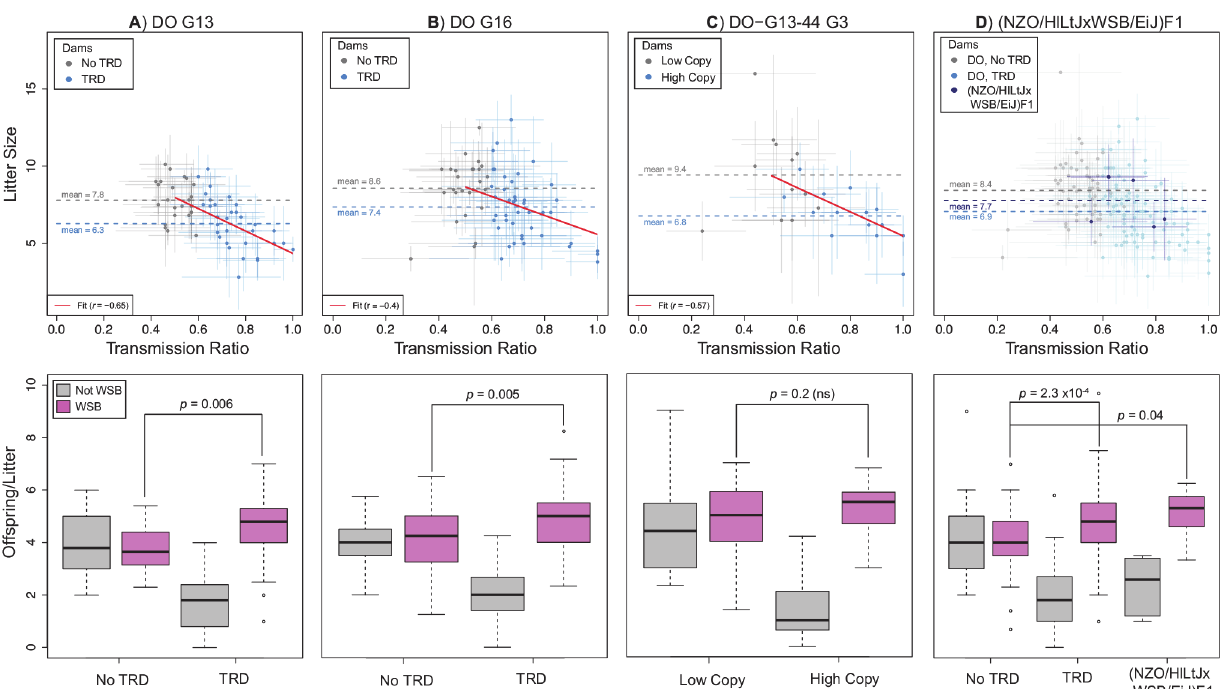
Figure 5. TRD at R2d2 requires the combined action of meiotic drive and embryonic lethality. Relationship between maternal TR and average litter size (top panels) and average number of offspring inheriting alternative alleles at R2d2 (bottom panels) for A) DO G13 dams, B) DO G16 dams, C) G3 dams in the D0-G13 – 44 pedigree and D) (NZO/HILtJxWSB/EiJ)F1 dams. Top panels: gray circles are dams without TRD (A, B, D) or having the low-copy allele (C); blue circles are dams with TRD (A, B, D) or having the high-copy allele (C). For each point, bars show standard error for TR (horizontal) and average litter size (vertical). Dotted lines show mean litter sizes for each type of female. Red line shows a linear fit to TR and average litter size. Bottom panels: left and right pairs of boxplots show average number of offspring per litter in females without and with TRD (A, B, D) or having the low- and high-copy allele (C) that inherit a WSB/EiJ (purple) or non-WSB/EiJ (gray) allele. Females with a mutant R2d2 WSB allele are excluded. Note that there are significantly more WSB/EiJ offspring of dams with TRD in F1 hybrid dams than in DO without